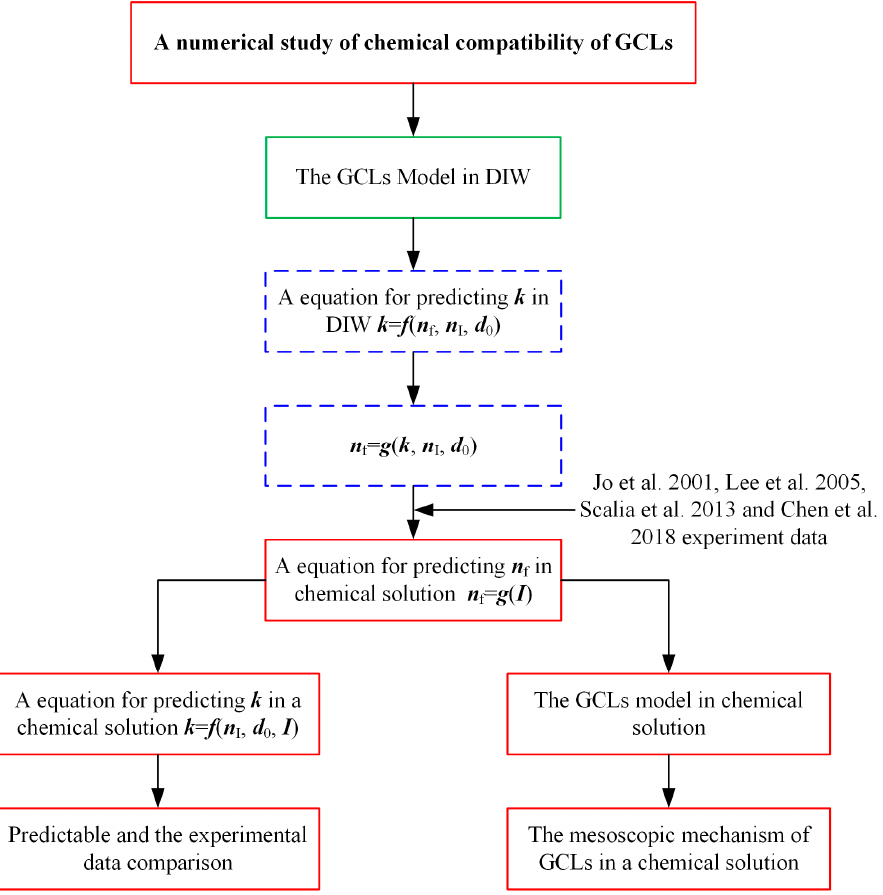
Figure 1. Flowchart for studying the mesoscopic mechanism of GCLs in a chemical solution.